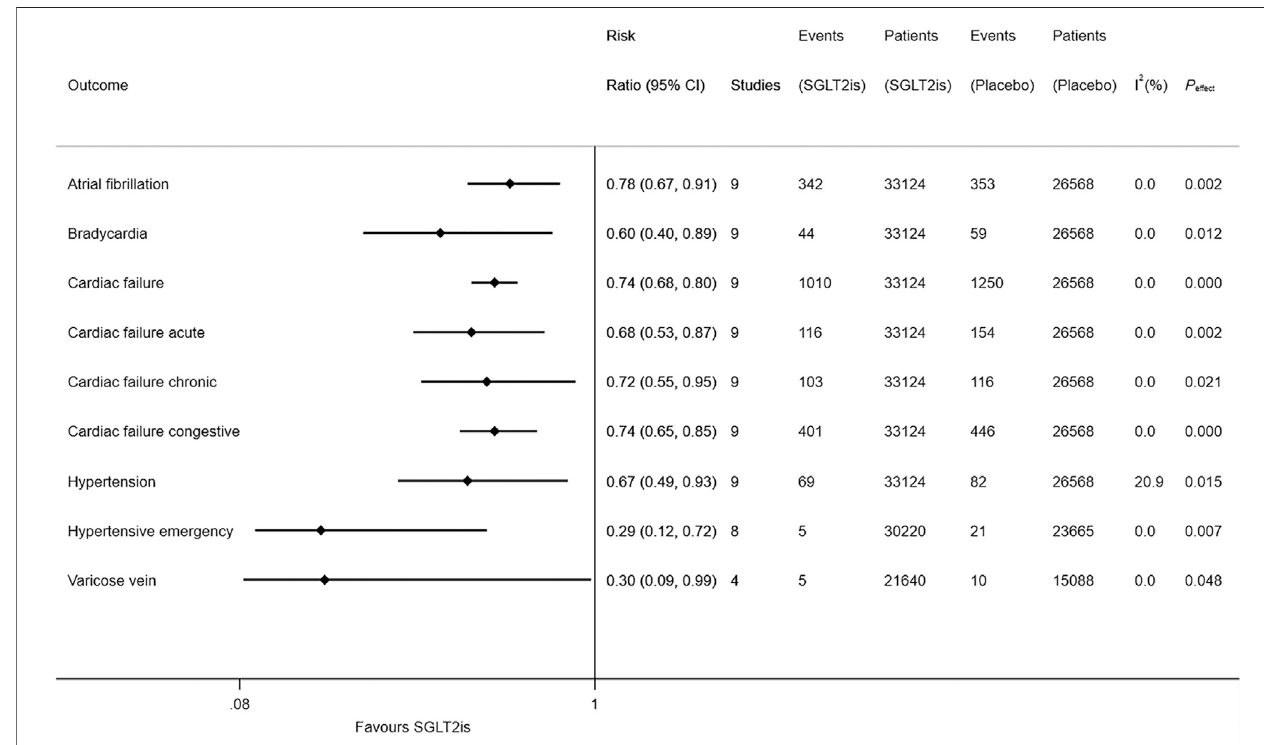
FIGURE 1 | Meta-analysis of SGLT2is and nine types of cardiovascular diseases.